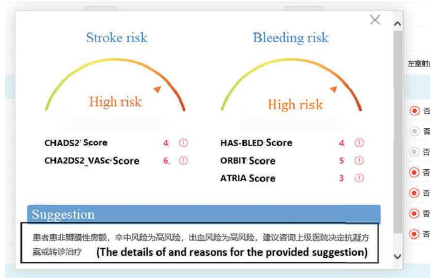
Figure 2: Examples of the treatment suggestions for initial patients.